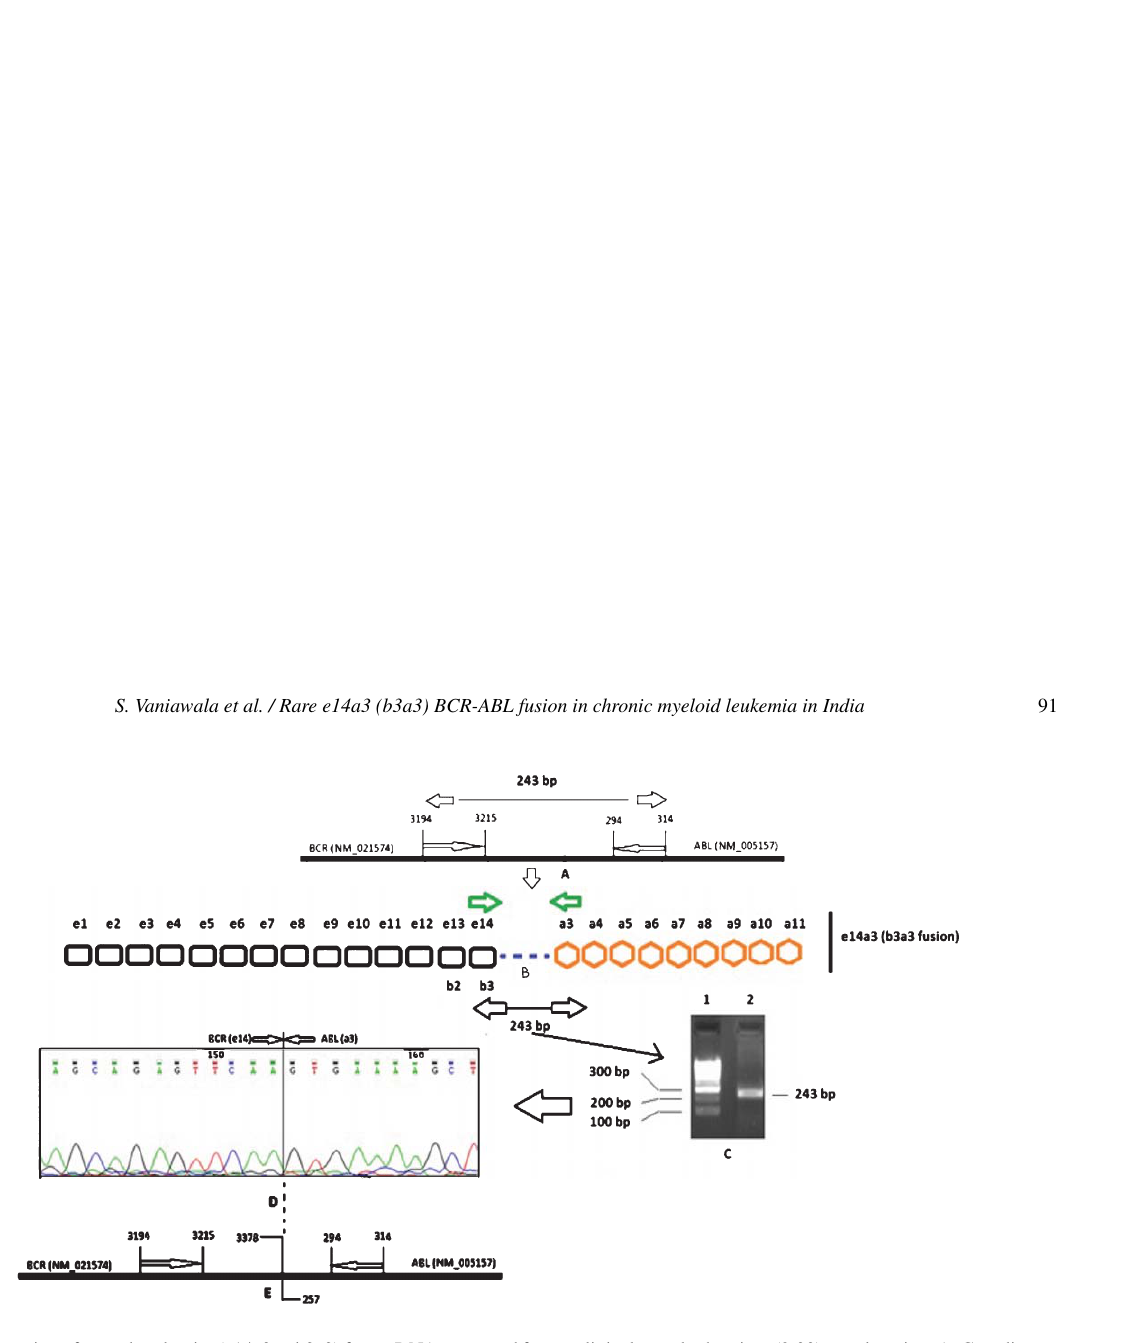
Fig.4. Detectionofararebreakpoint(e14a3orb3a3)fromcDNAgeneratedfromaclinicalsampleshowingt(9;22)translocation.A:Coordinates of the BCR and the ABL gene where the forward and the reverse primers hybridize respectively to generate the 243bp PCR amplicon. B: Exonic regions of the BCR and the ABL genes that were amplified for detection of the e14a3 breakpoint. C: A 243bp PCR amplicon generated that contain the rare e14a3 breakpoint. D: Electropherogram showing the exact point of fusion of the BCR and ABL genes to generate the e14a3 breakpoint. E: Schematic diagram showing nucleotide positions of the BCR and the ABL genes respectively where break occurred to generate the e14a3